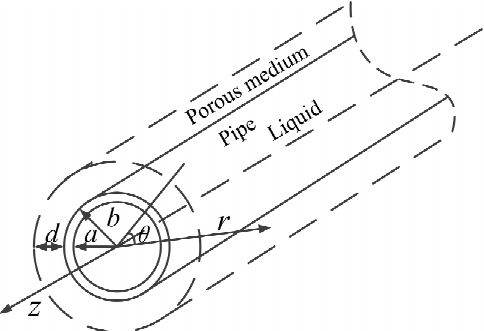
Figure 1. Model geometry of a liquid-filled pipe embedded in porous medium.